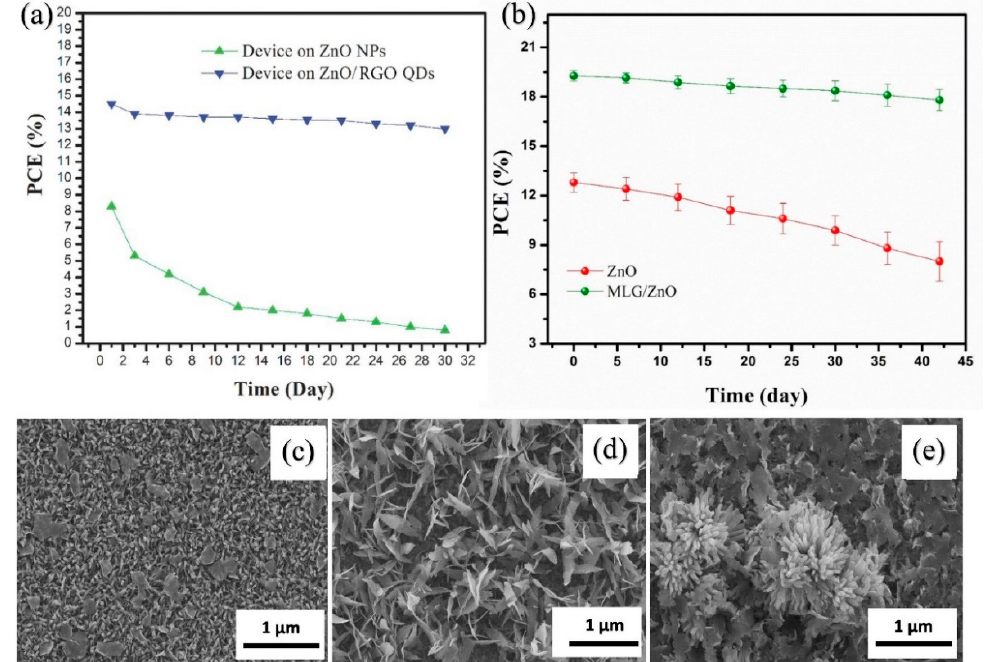
Figure 6. ( a ) Stabilities of PSCs with ETLs of ZnO nanoparticles (NPs) and ZnO / RGO QDs in ambient conditions after encapsulation over 30 days [81] (republished with permission from WILEY); ( b ) Stabilities of PSCs with ETLs of ZnO and ZnO with monolayer-GR (MLG / ZnO) in ambient conditions with 30% humidity over 42 days [43] (republished with permission from the Royal Society of Chemistry); top-view SEM images of ZnO nanorods modified by nitrogen-doped GR at concentration of ( c ) 0.4 wt %, ( d ) 0.8 wt %, ( e ) 1.0 wt % [74] (republished with permission from